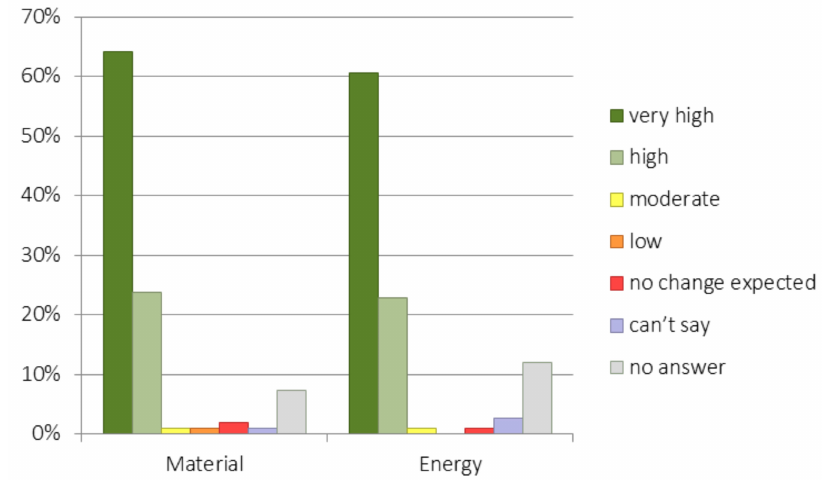
Figure 2. Expected saving